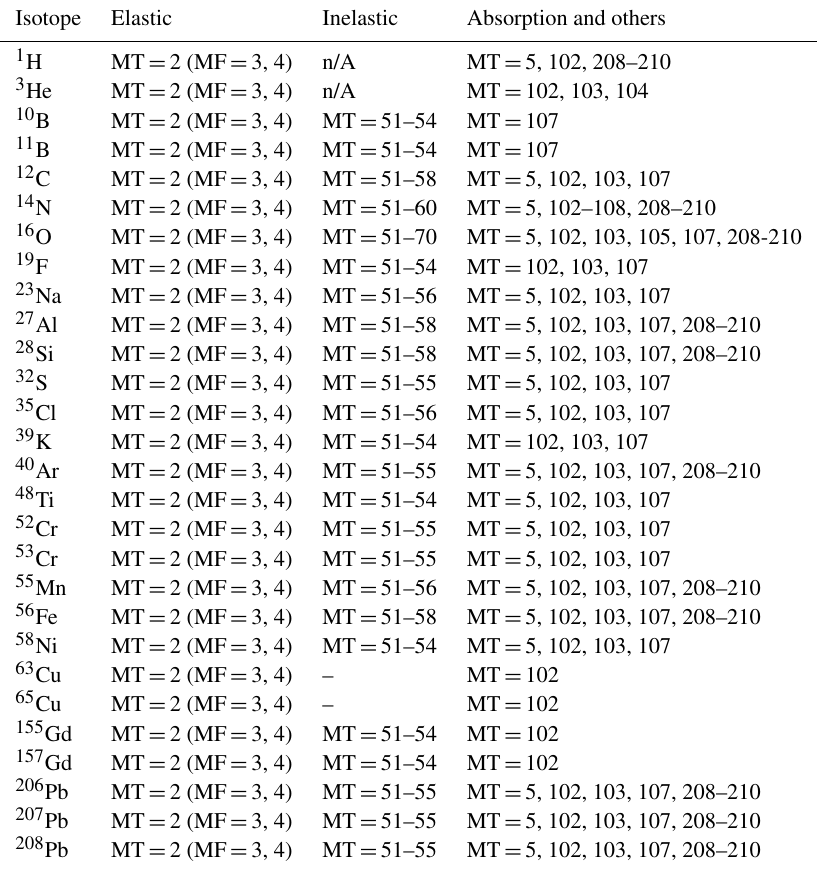
Table A1. Available isotopes in URANOS and cross sections used, identifiers according to Trkov et al. (2012). Isotope Elastic Inelastic Absorption and